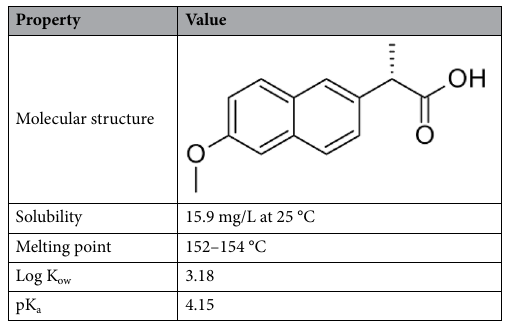
Table 1. Physical and chemical properties of